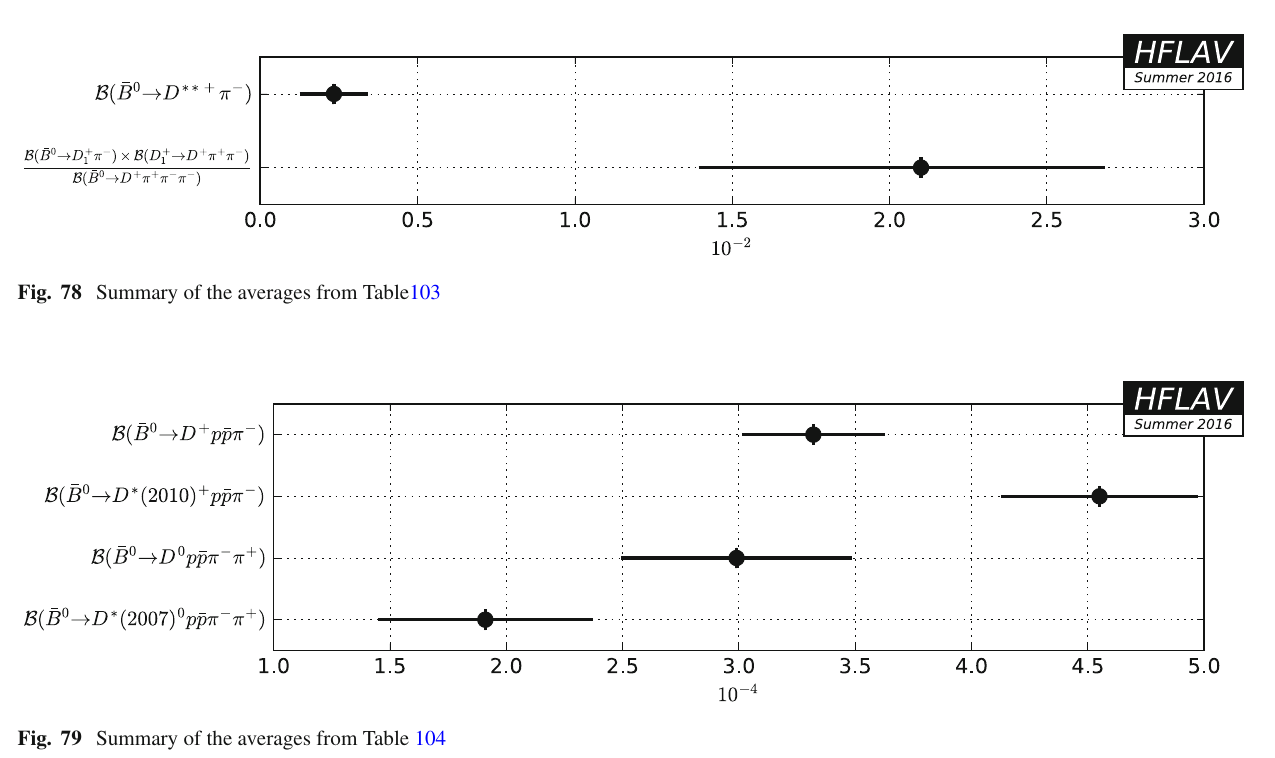
Fig. 77 Summary of the averages from Table 102